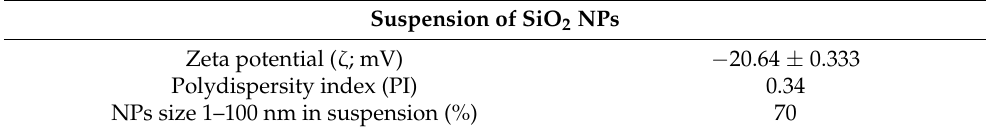
Table 1. Properties of SiO 2 NPs suspension in DI water (pH = 7.05): zeta potential, results represent the mean ± standard error, polydispersity index, and percentage of nanoparticles between 1–100